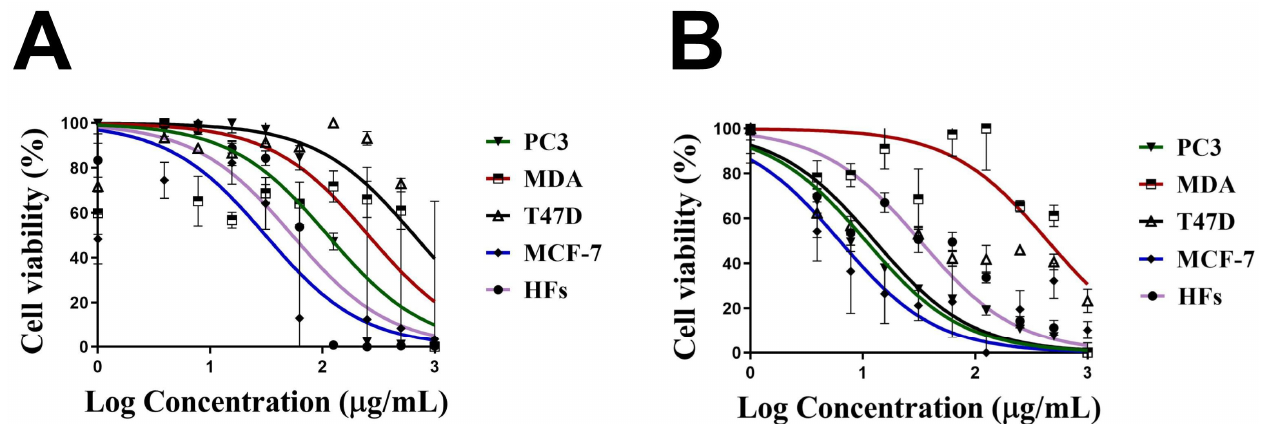
Figure 11. Cell viability of 1000 µ g/mL of chemically synthesised Ag-NPs (Ch@Ag-NPs) ( A ) and 5-fluorouracil (5-FU) ( B ) against four malignant cells, PC3, MDA-MB-231, T47D, and MCF-7, and normal cells, HFs. Data are represented as mean ± SEM.